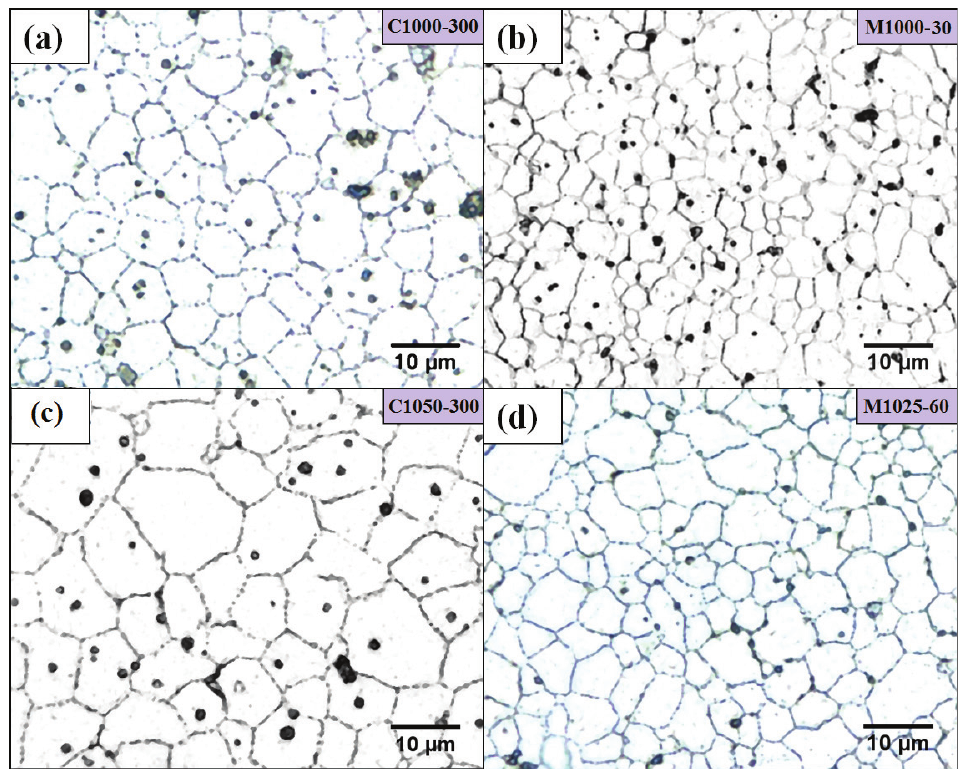
Figure 5. Optical micrographs under 1000X magnification for the samples C1000-300 (a), M1000-30 (b), C1050-300 (c) and M1025-60 (d).